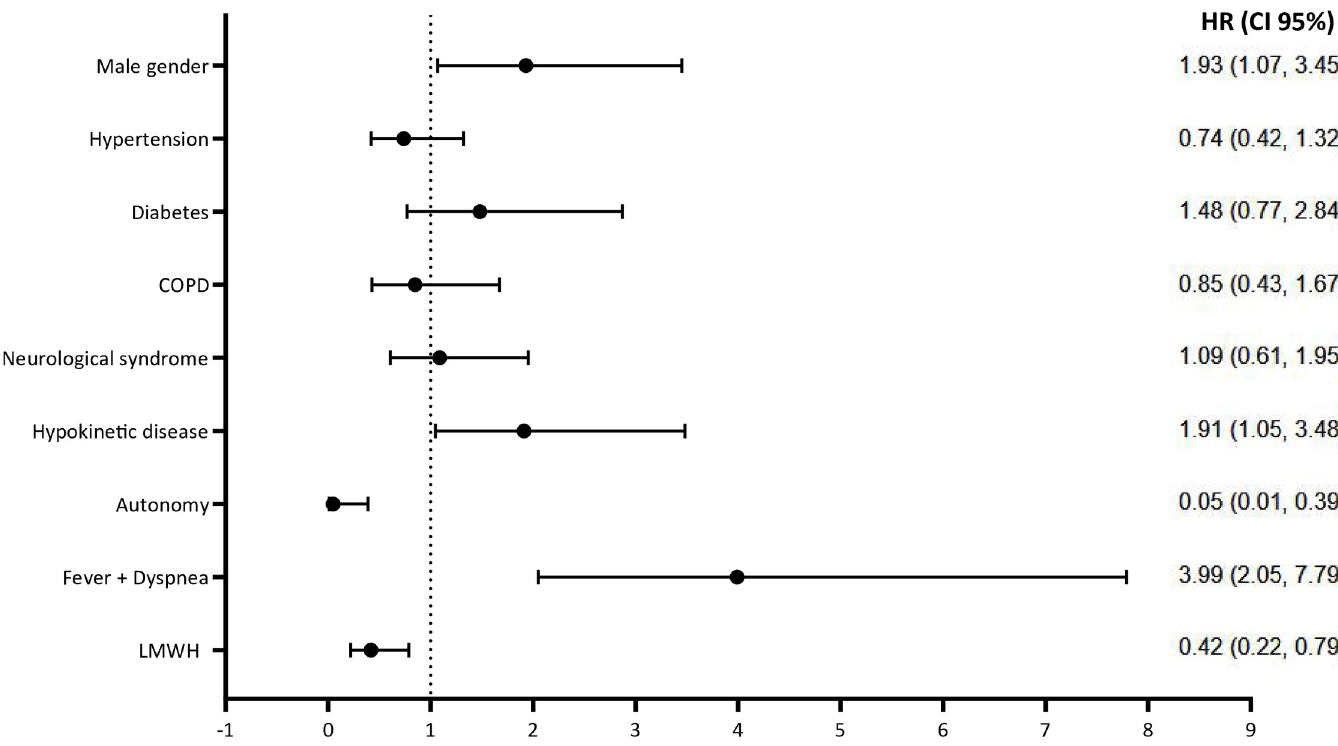
Fig 3. Forrest Plots of multivariate Cox proportional hazards model regression estimates of factors associated with mortality. Multivariable model includes all variables selected by a backward selection that were retained with a p-value less than 0.2 level. HR: Hazard Ratio; CI: Confidence Interval; COPD: chronic obstructive pulmonary disease; LMWH: low molecular weight